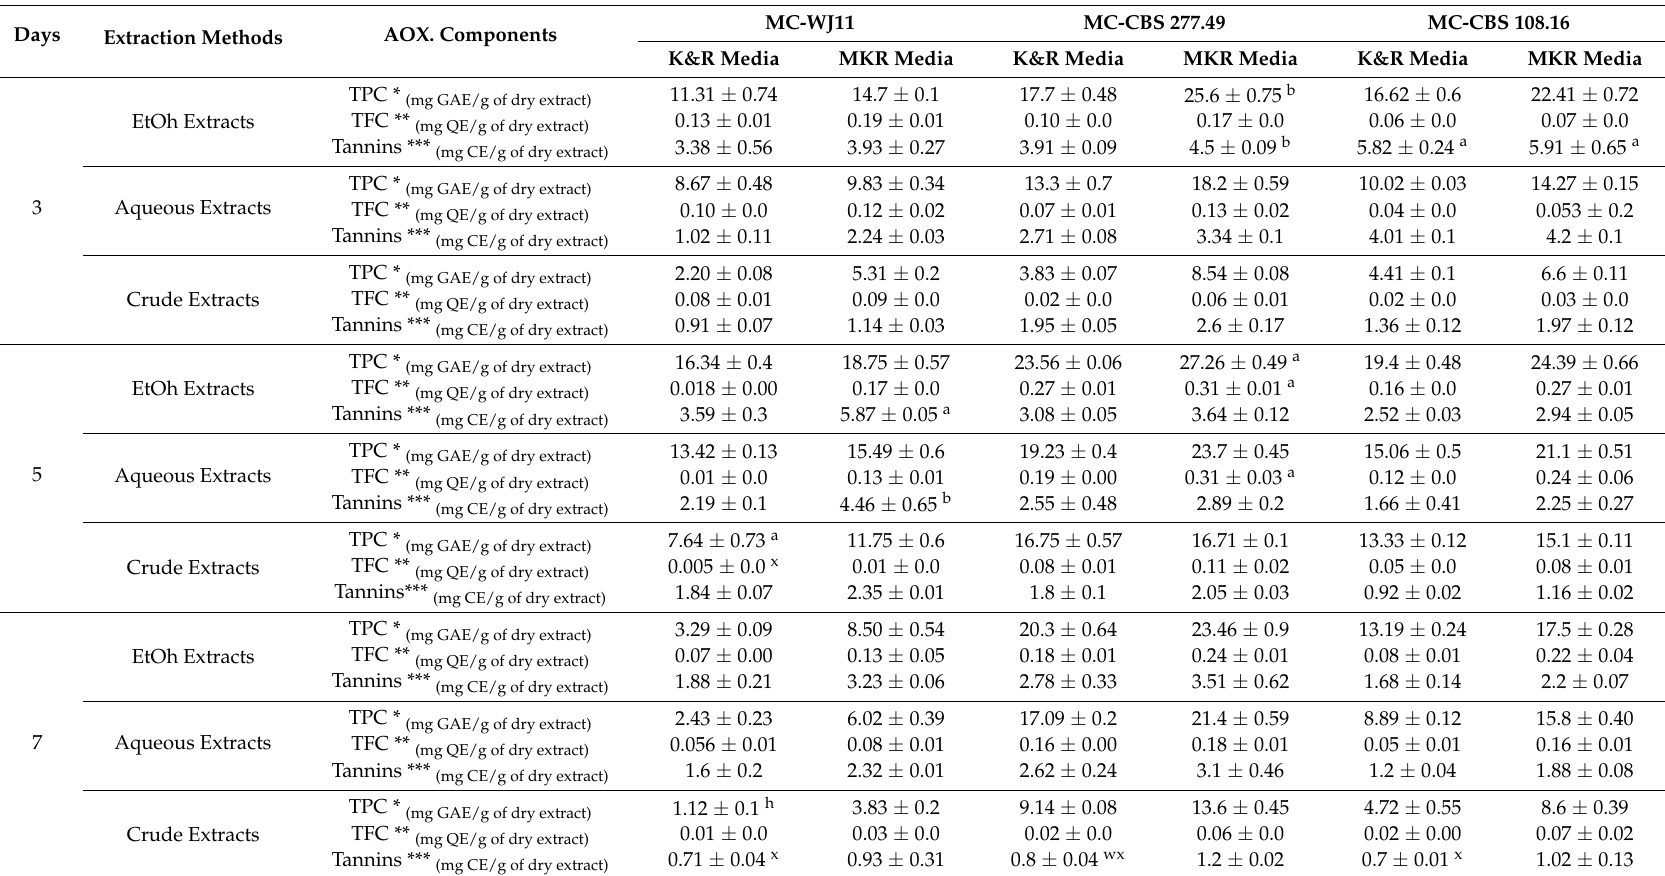
Table 2. Summary of antioxidant components found periodically in each selected strain in their three